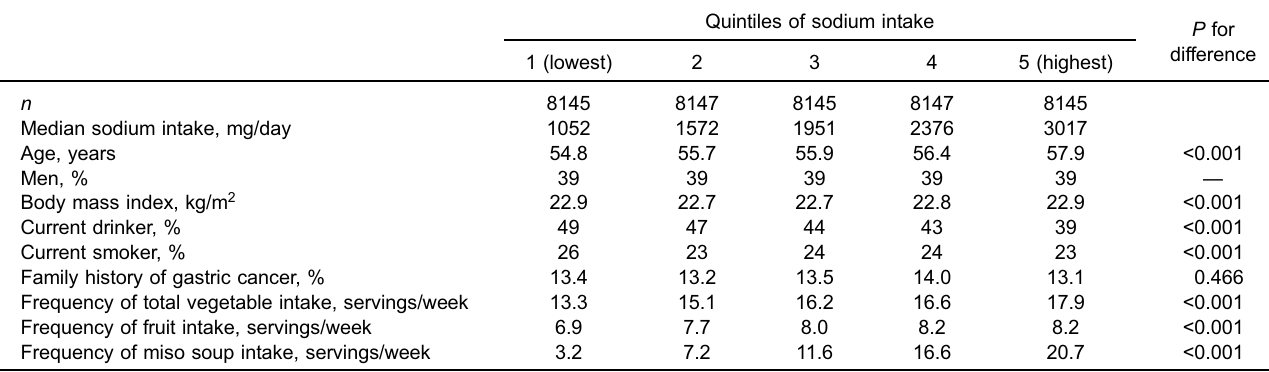
Table 3. Age- and sex-adjusted characteristics of the subjects according to sex-speci fi c quintiles of sodium intake Quintiles of sodium intake P for